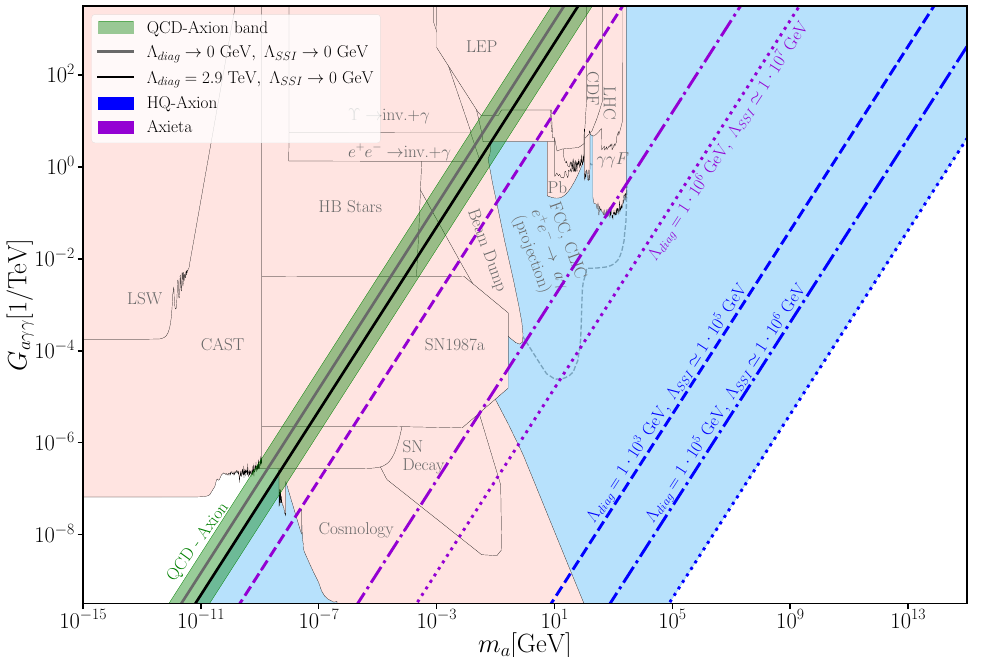
Figure 6 . Axion bands of the color unified model variant M2 in the m a vs. G aγγ plane. The band in green shows canonical DFSZ- and KSVZ-models, while the pink shaded regions show the current experimental bounds on axions and ALPs [58–69], and we include a contour from a future projection of CLIC sensitivity from ref. [70]. The blue shaded region shows the possible parameter space for the new HQ-axion a 0 and the axieta a enhanced by SSI effects, where lines in blue and violet show chosen models with the corresponding scales Λ diag and Λ SSI . A lower and upper bound on the Λ diag and Λ SSI scales arises because of experimental constraints on new color gauge group extensions discussed in the main